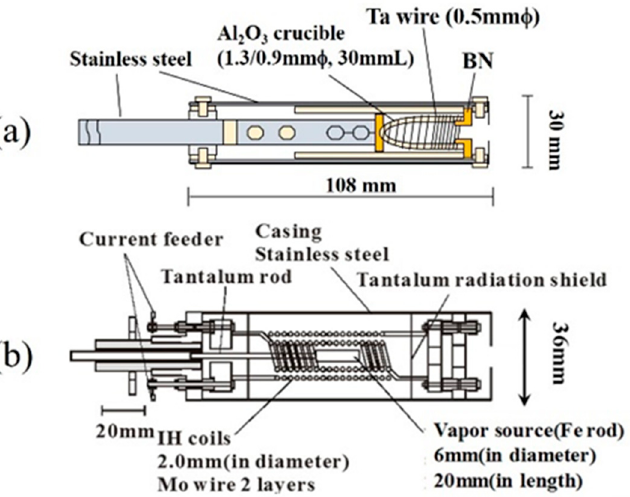
Figure 2. Schematic diagram of fullerene evaporation source ( a ) and induction heating (IH)-type iron evaporation source ( b ).